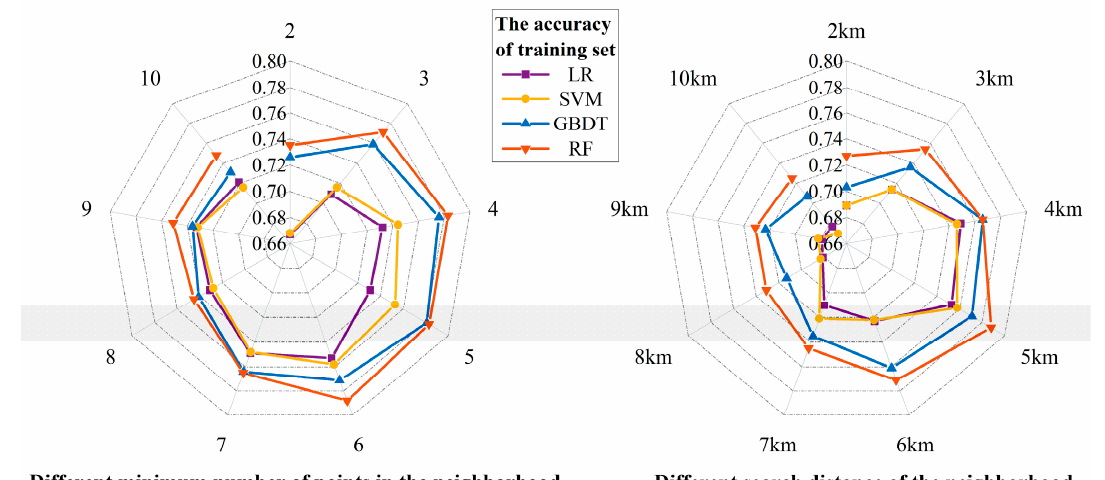
ISPRS Int. J. Geo-Inf. 2022 , 11 , x FOR PEER REVIEW 4 of 13